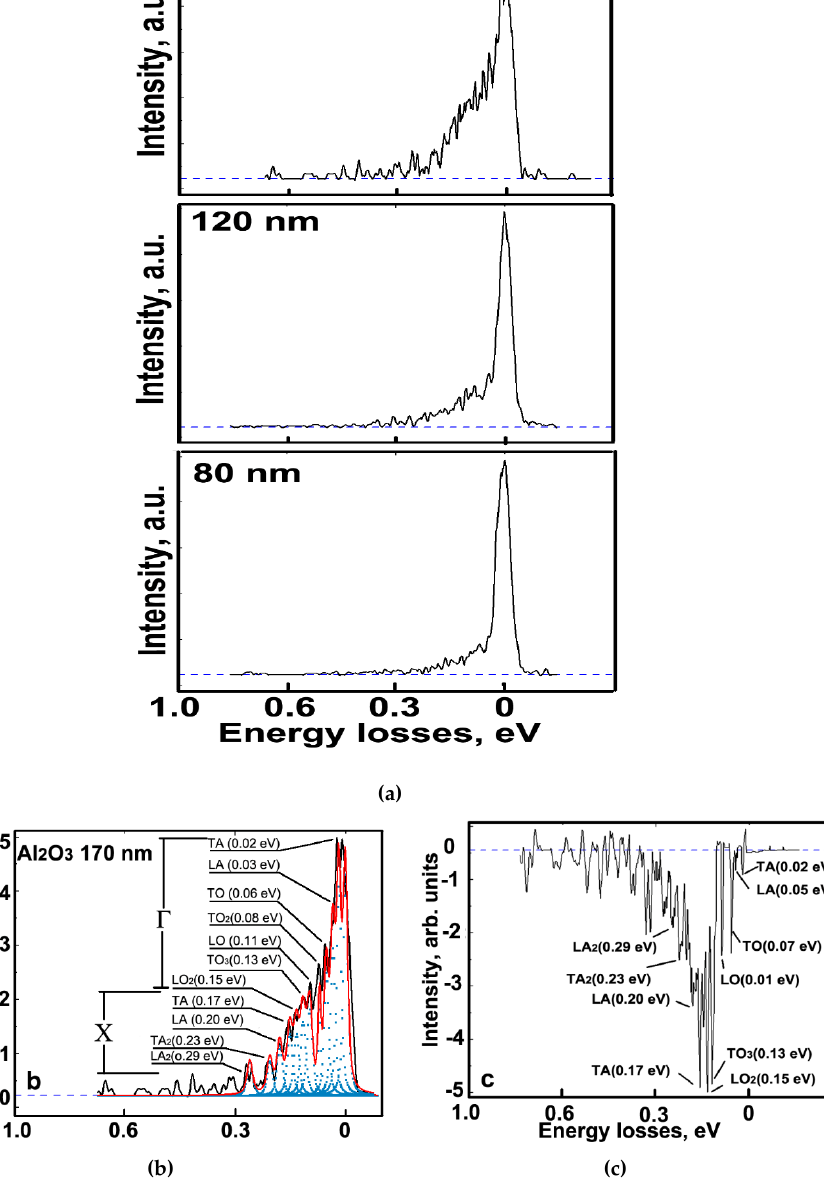
Figure 7. Comparison of phonon HREEL spectra of 170, 120, and 80 nm Al 2 O 3 layers ( a ); fine structure of phonon spectra in 170 nm Al 2 O 3 layer ( b ); the differentiation of HREELS acquired from 80 nm and 170 nm Al 2 O 3 layers ( c ).